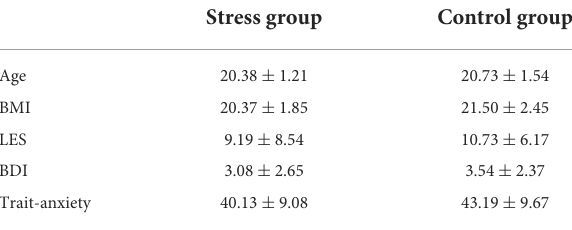
TABLE 1 Characteristics of the participants in the stress and control groups (M ±